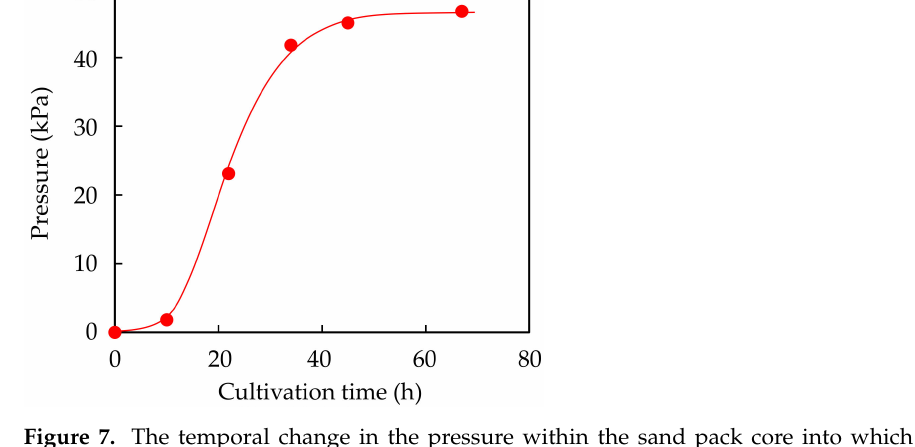
Figure 7. The temporal change in the pressure within the sand pack core into which the CO 2 nanobubble medium was injected during the in situ cultivation of P. aeruginosa .